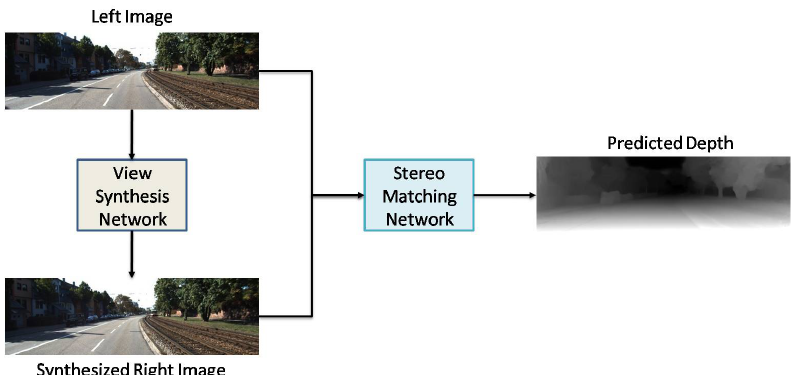
Figure 15. Components/inputs of developed semi-supervised loss function by Luo et al. [41].